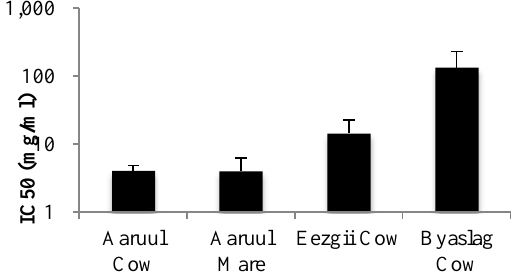
Fig.1. ACE inhibitory activities of various types in Mongolian traditional milk products.